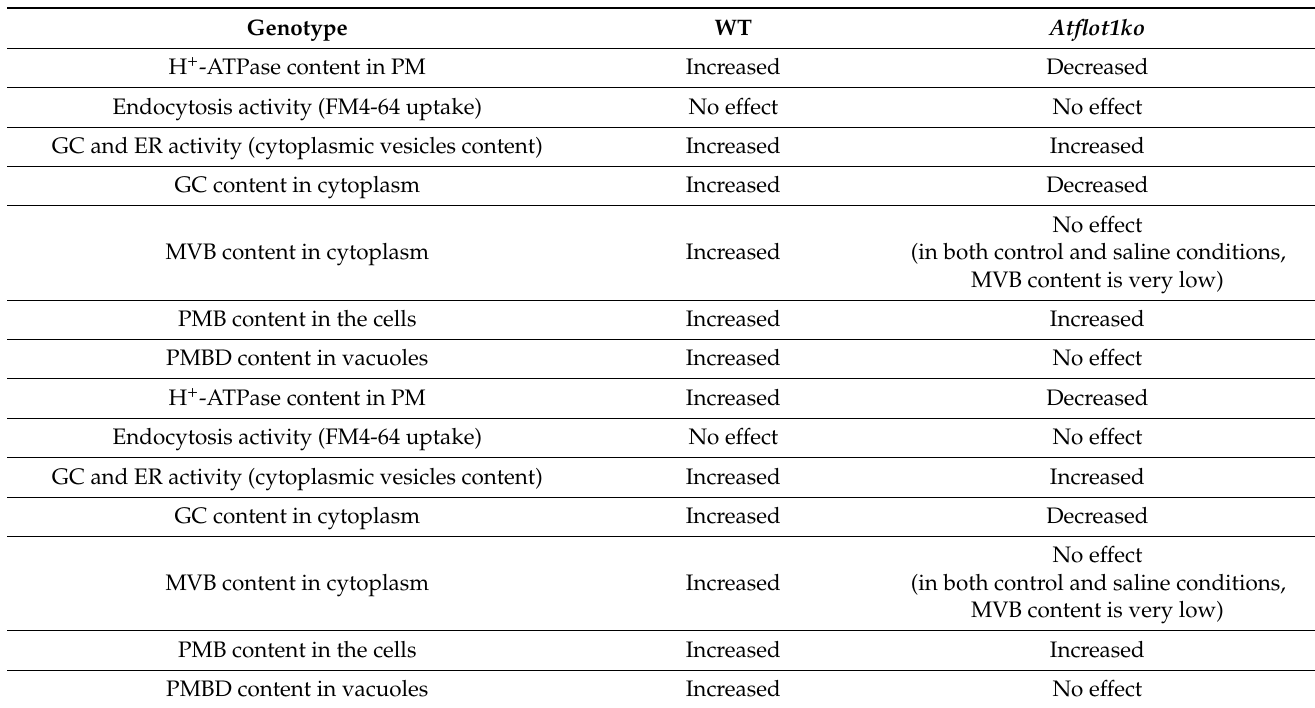
Table 2. The effects of NaCl on the H + -ATPase content in PM, endocytosis activity, and content of membrane-bound intracellular structures in A. thaliana plants of WT and the knockout mutant, Atflot1ko